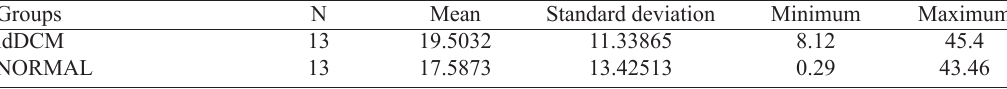
Table 7. Descriptive measures of variables elastic fibers of RVR in idDCM and NORMAL groups (percentage). Groups idDCM